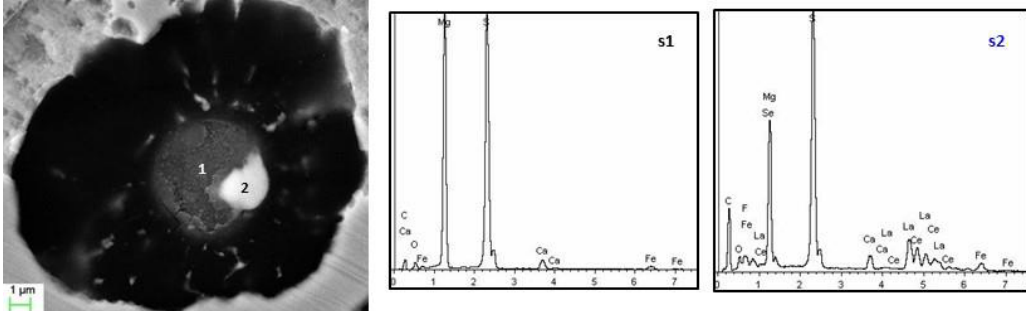
Figure 11. SEM images of a graphite nucleating on a selenide, and corresponding WDX/SEM spectrums, at different positions: position 1 − (Mg,Ca) S; position 2 − (Mg,Se,Ca,Ce,La) S.